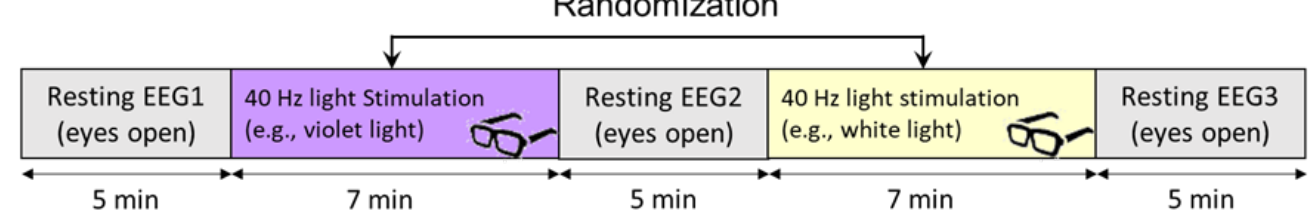
Figure 2. A schematic diagram of the experiment in this study.